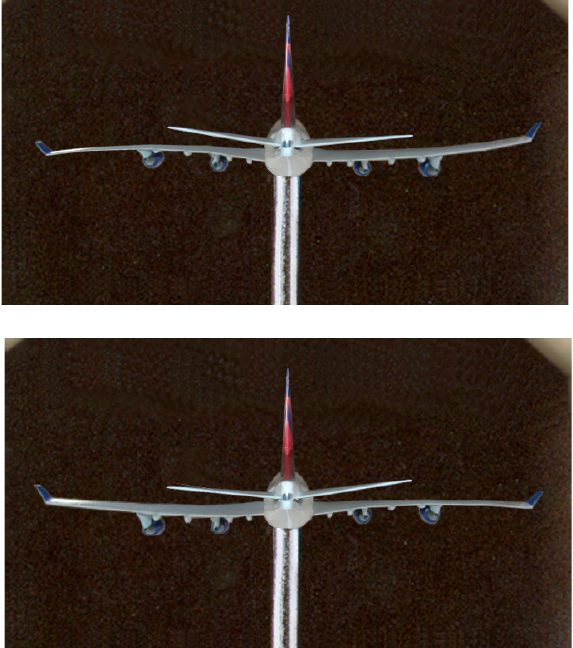
Figure 8. Flutter occurring at Mach 0.63. The two photographs were taken 0.098 s